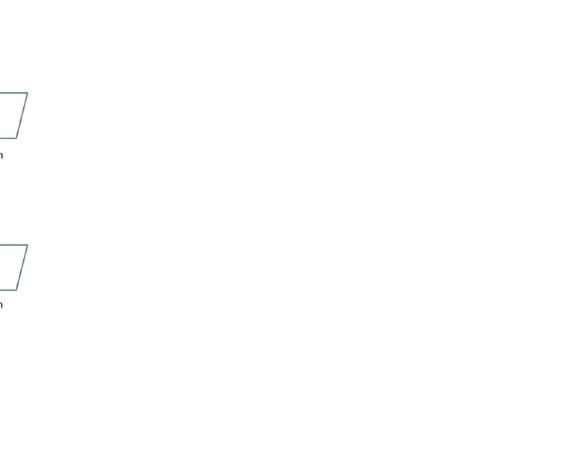
to maintain their head stationary while rotating the eye towards each gaze position.